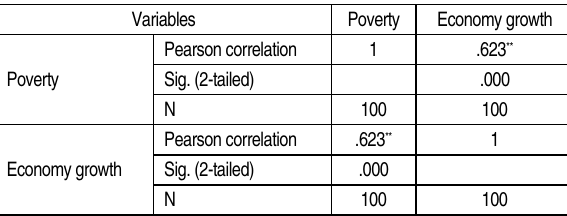
Table 7. Correlation between poverty and